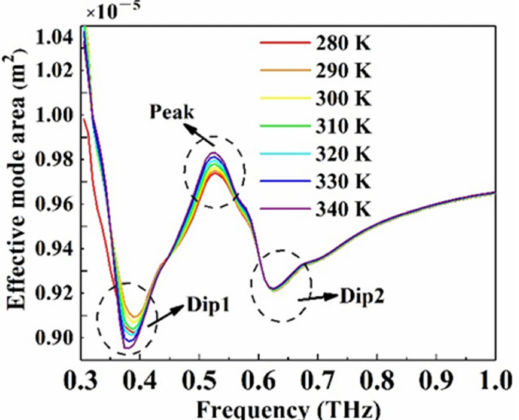
Figure 4. Effective mode area of the fundamental mode with water at different temperatures.